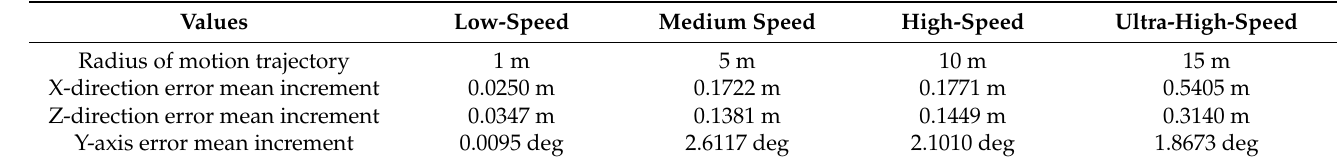
Table 3. The increment of position error in different work condition.